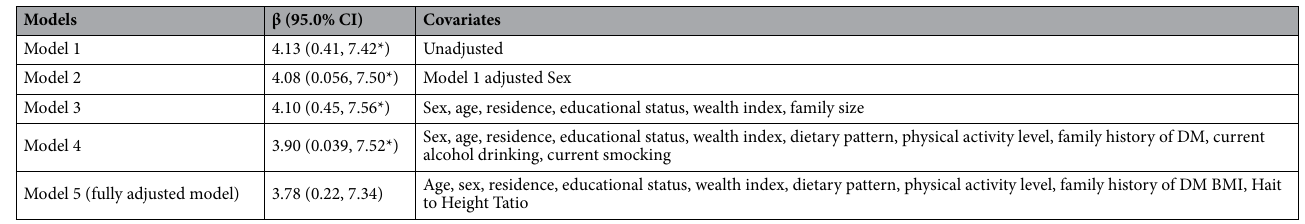
Table 2. Association of prenatal famine exposure and fasting plasma glucose among adults, a linear regression analysis, Wollo, Ethiopia. *Significant at P < 0.01, **significant at P < 0.05, fasting blood sugar, BMI; body mass index, BP; blood pressure. All β-coefficients (95% CI) were from multiple linear regression analysis, and related to the non-exposed groups.